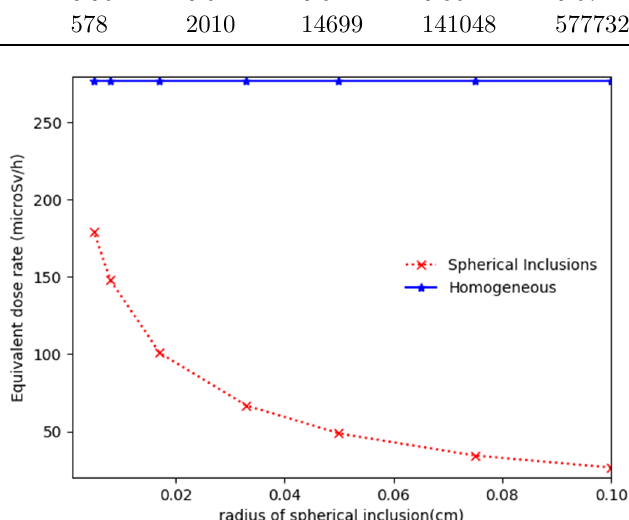
Fig. 7. RSA spherical inclusion method, Gamma simulations with different values of the sphere radii with a constant mass of 1g for each corner and constant density of 6.6 g/cm 3 (relative standard deviation inferior to 1%, given in Tab. 2, are not presented on the fi